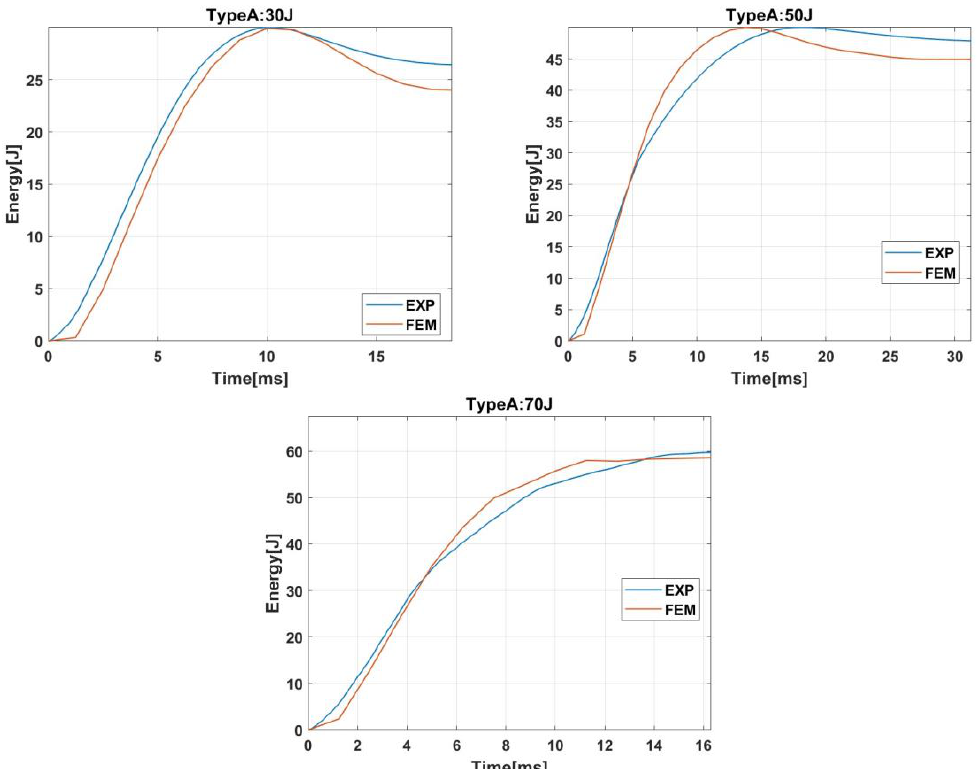
Figure 7. Energy history of bumper beam type A under impact energies of 30 J, 50 J, and 70 J.